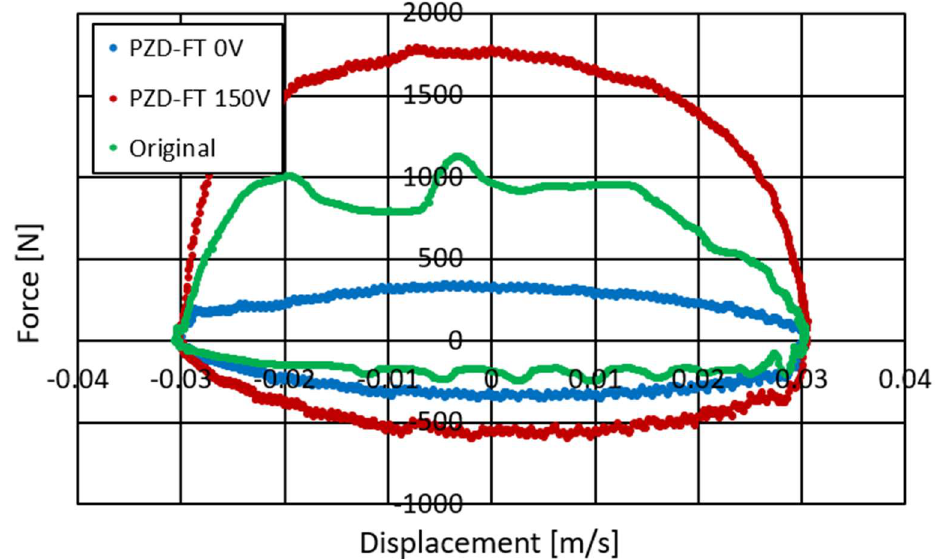
Figure 7. Experimental results of the PZD damper on the displacement-force plane, kinematic excitation with a frequency of 1 Hz, amplitude of 0.030 m, voltage of 0–150 V: PZD-FT 0 V (blue)—PZD without supplying voltage (0 V), PZD-FT 150 V (red)—PZD with supplying voltage (150 V), Original (green) factory passive damper.